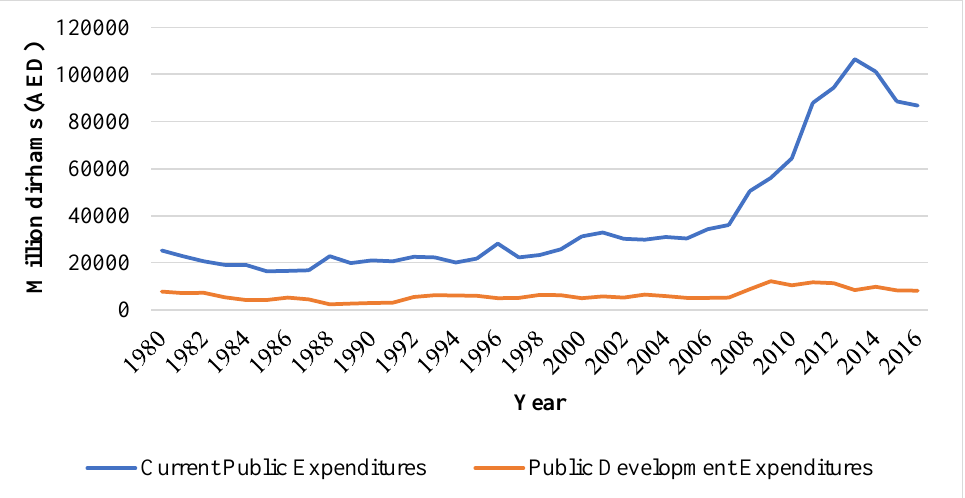
Fig. 2. Current and development expenditures in the UAE during the period 1980–2016 (real values in a million dirhams) (Central Bank of the UAE Publications, Federal Competitiveness and Statistics